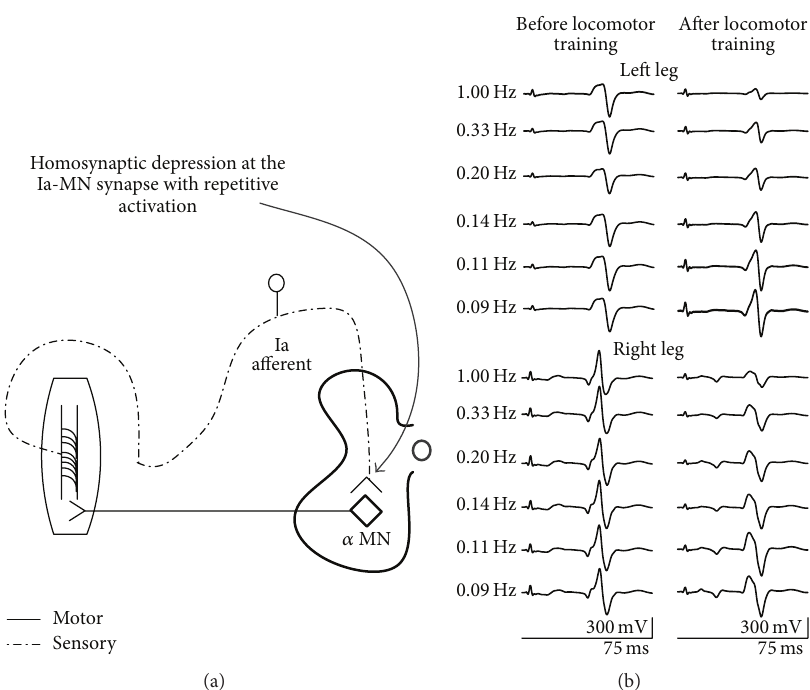
Figure2:FunctionalreorganizationofhomosynapticdepressionafterlocomotortraininginSCI.(a)SchematicdiagramofthesoleusH-reflex homosynaptic depression exerted at Ia-motoneuron synapse with repetitive activation of Ia afferents. (b). Nonrectified waveform averages of soleus H-reflexes recorded at different stimulation frequencies from one AIS B patient before and after locomotor training for both legs. The soleus H-reflex amplitude exhibited a strong stimulation frequency-dependent depression after locomotor training. Data adopted and modified from